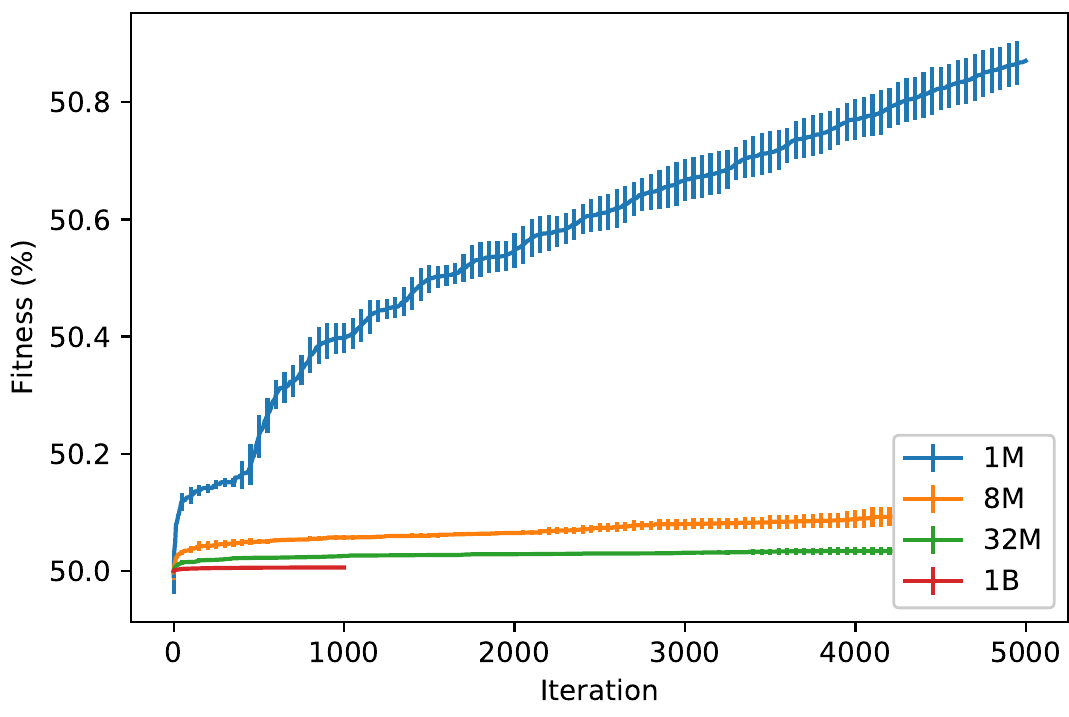
Figure A4. Best fitness value per iteration (mean ± std. dev. across 10 runs per algorithm) for the cGA on the continuous OneMax problem in four different